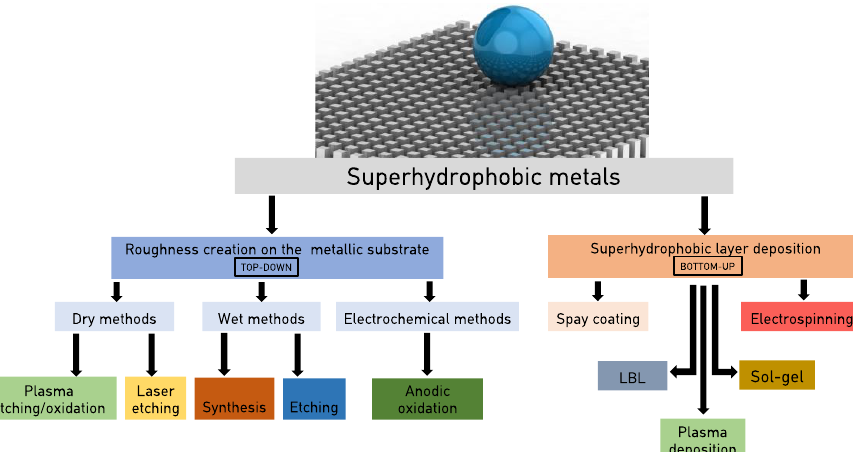
Figure 1. Overview of the fabrication methods used to transform metal surfaces to superhydrophobic. LBL: Layer by layer deposition.